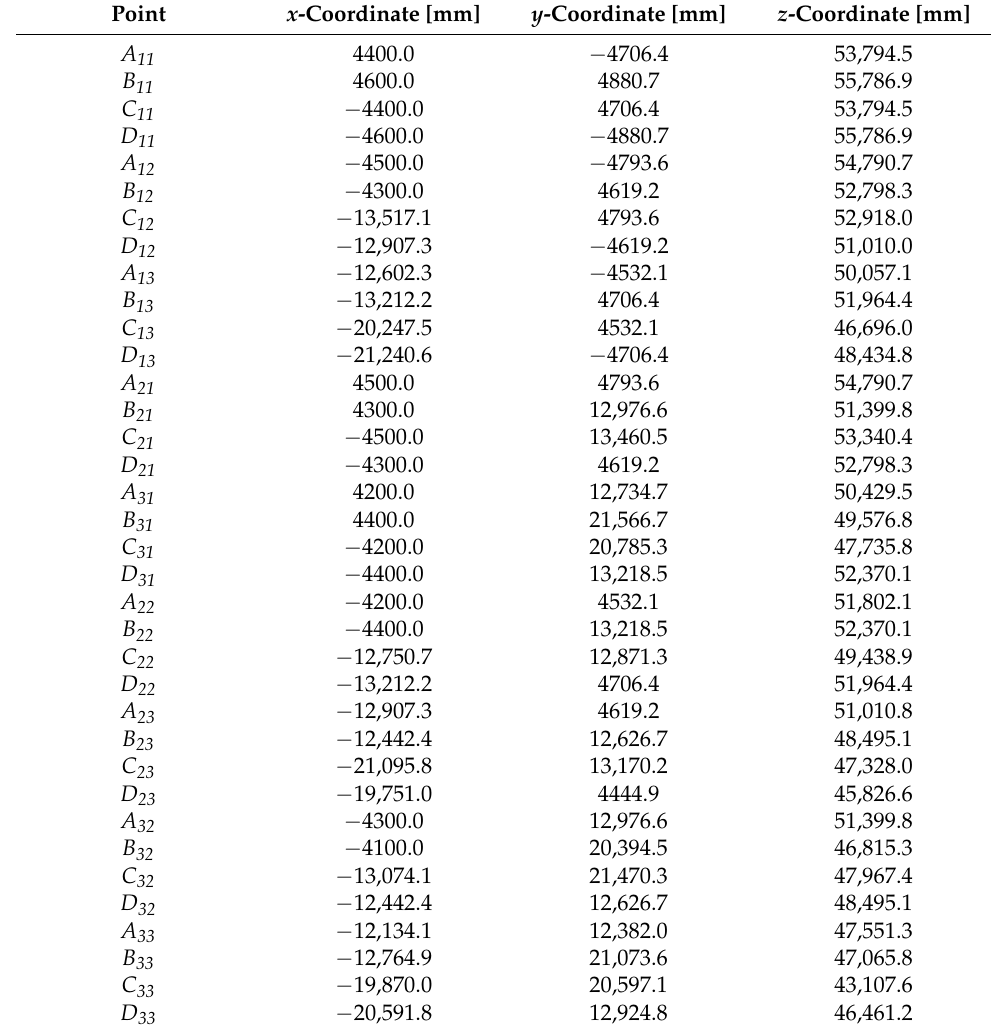
Table A9. The coordinates of the vertices A ij , B ij , C ij , D ij (for i, j = 1, 2, 3) of the second modified configuration CP2 of the eaves edge net B v 1